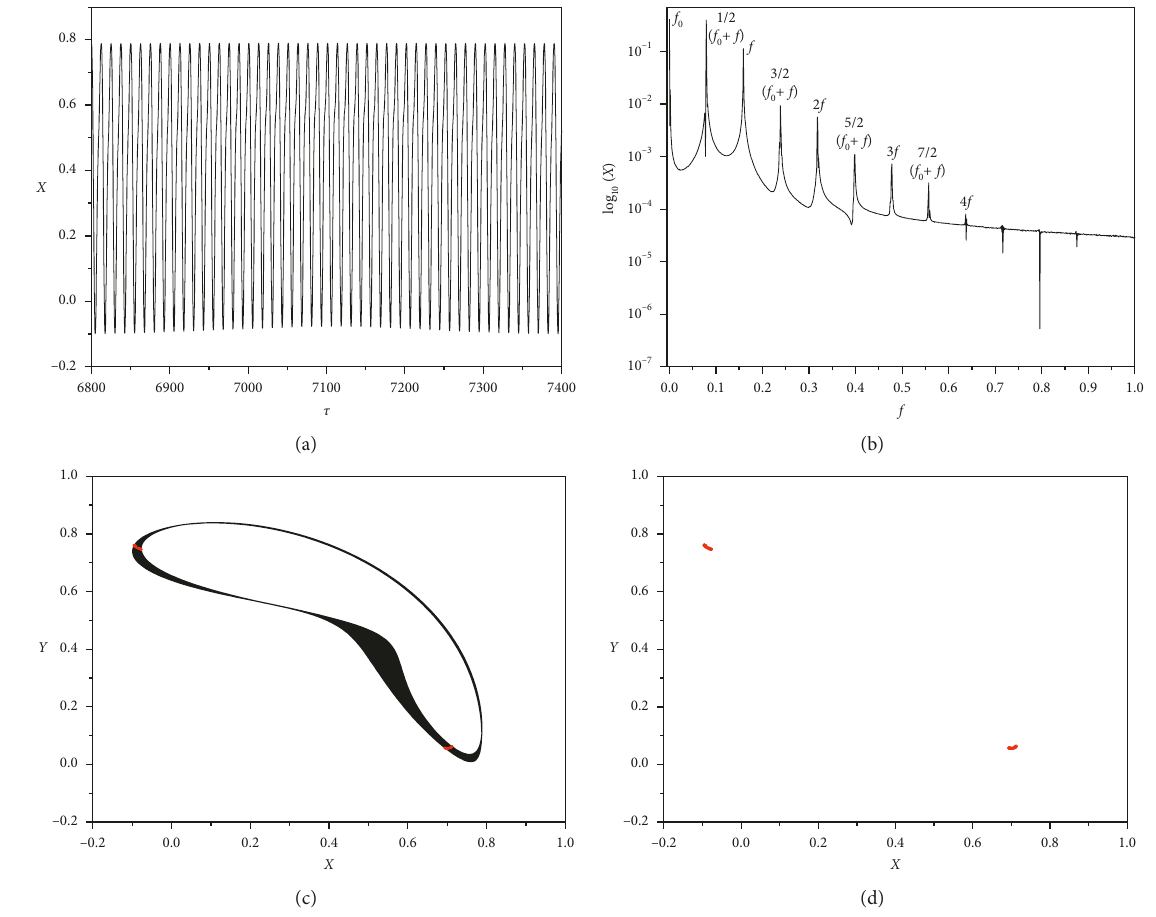
Figure 6: (a) Displacement. (b) Frequency response. (c) Rotor orbit. (d) Poincar´e map where